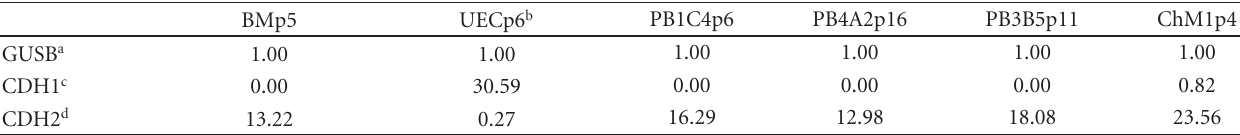
Table 2: Transcript analysis of E-cadherin and N-cadherin in clonal and mixed cell populations of amniotic cells.